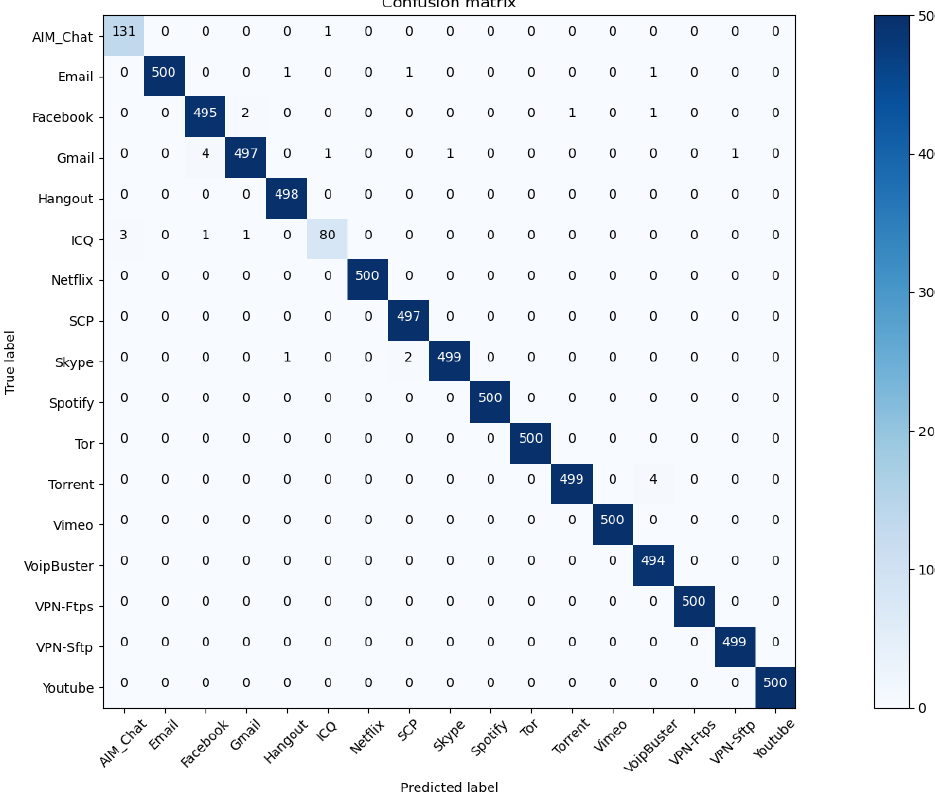
Figure 4. Confusion matrix for application